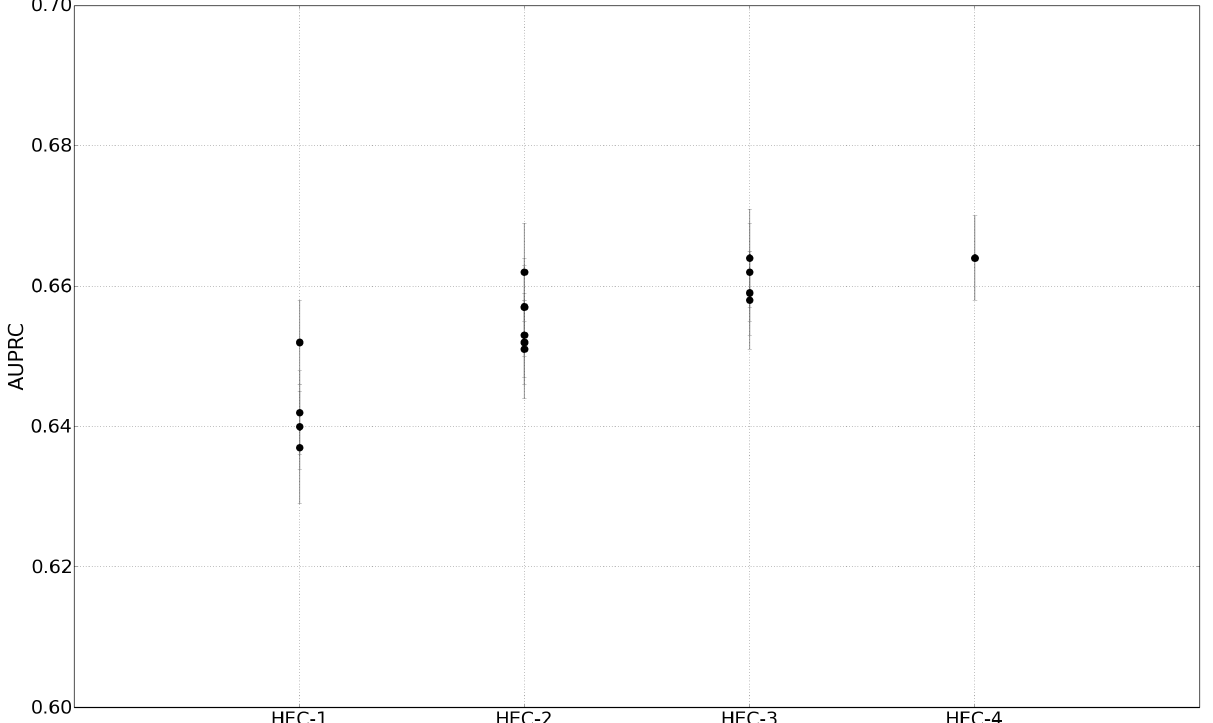
Figure 5. Comparison Between heterogeneous classifiers HEC-1 and HEC-N trained on cancer, depression, hypertension, and leukemia, and tested on the remaining 30 health issues. The tweets of each test health issue stratified with respect to their rate of